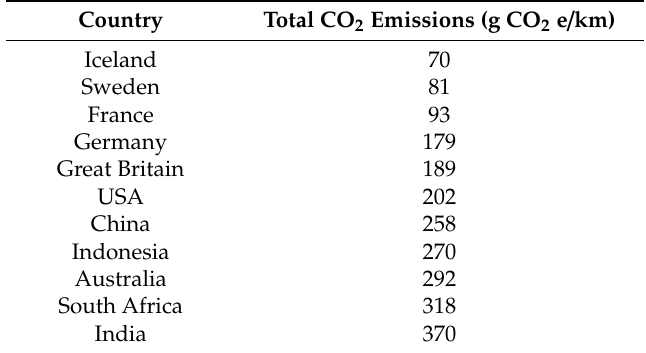
Table 2. Average emissions of electric vehicles in selected countries [16].